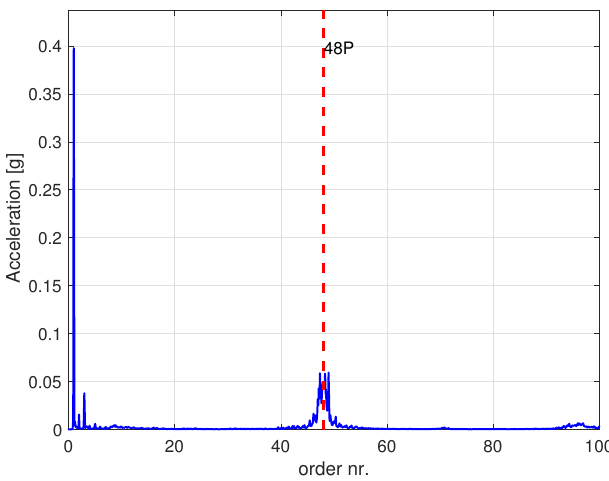
Figure 9. Order spectrum of the experimental Y direction tower oscillations.